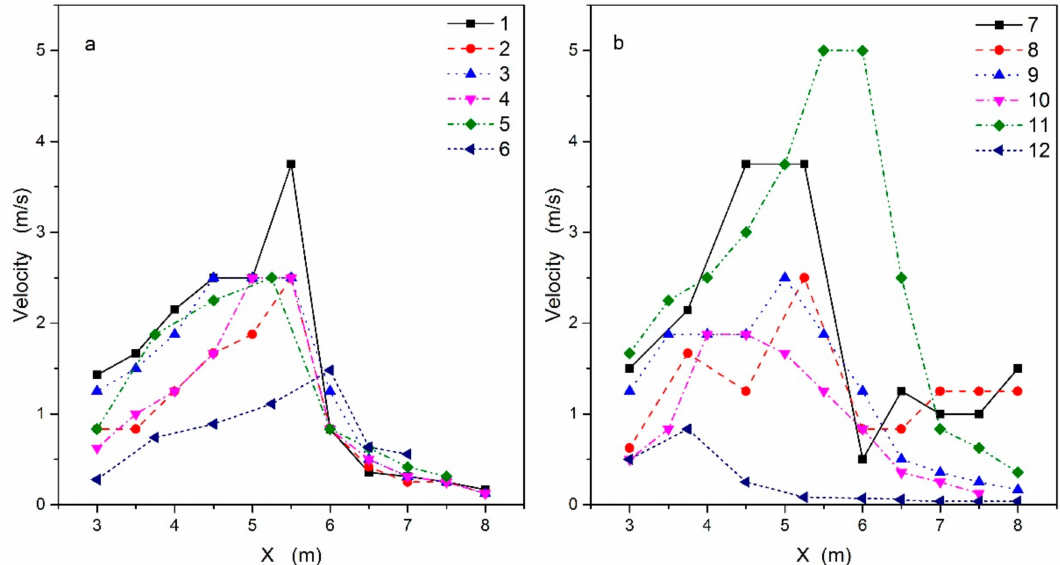
Figure 6. Velocity measurements for all the different experiments conducted. ( a ) shows the velocity along the channel for each test when the slope of the flume was 20 ◦ , ( b ) shows the velocity along the channel for each test when the slope of the flume was 25 ◦